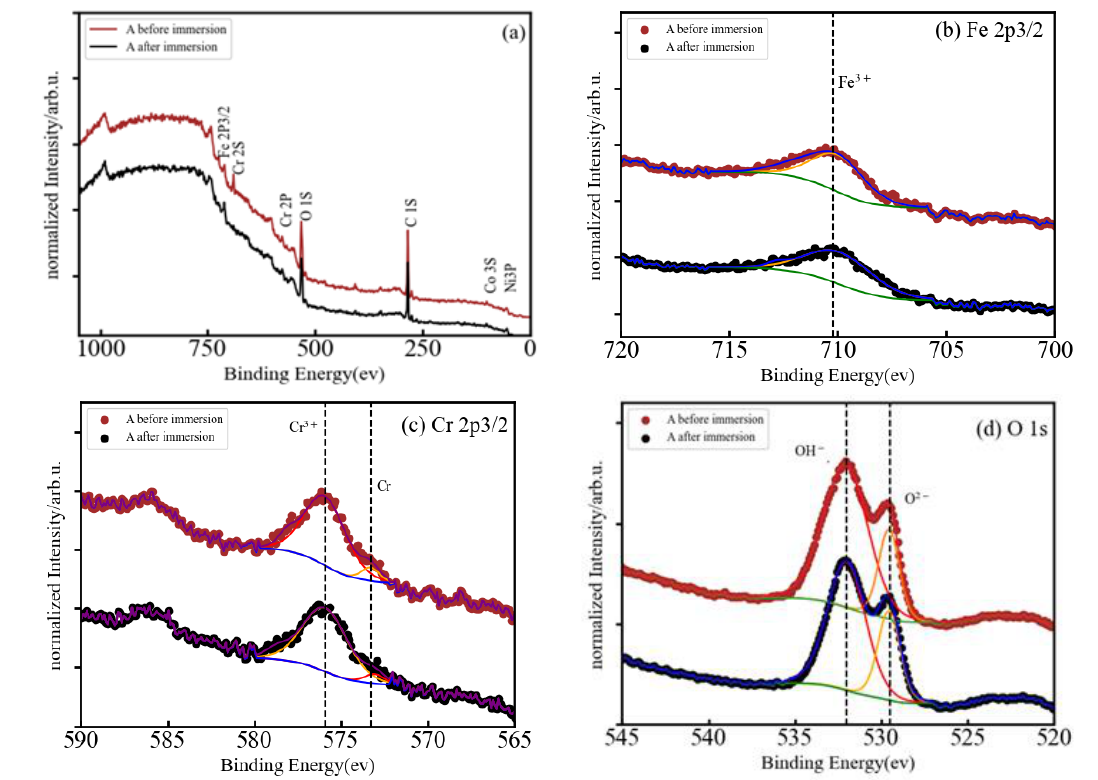
Figure 4 ( a ) Normalized XPS spectrum of A after immersion in 3 wt.% NaCl, and ( b – d ) high-resolution XPS spectra of Fe 2p3/2, Cr 2p3/2, and O 1s.